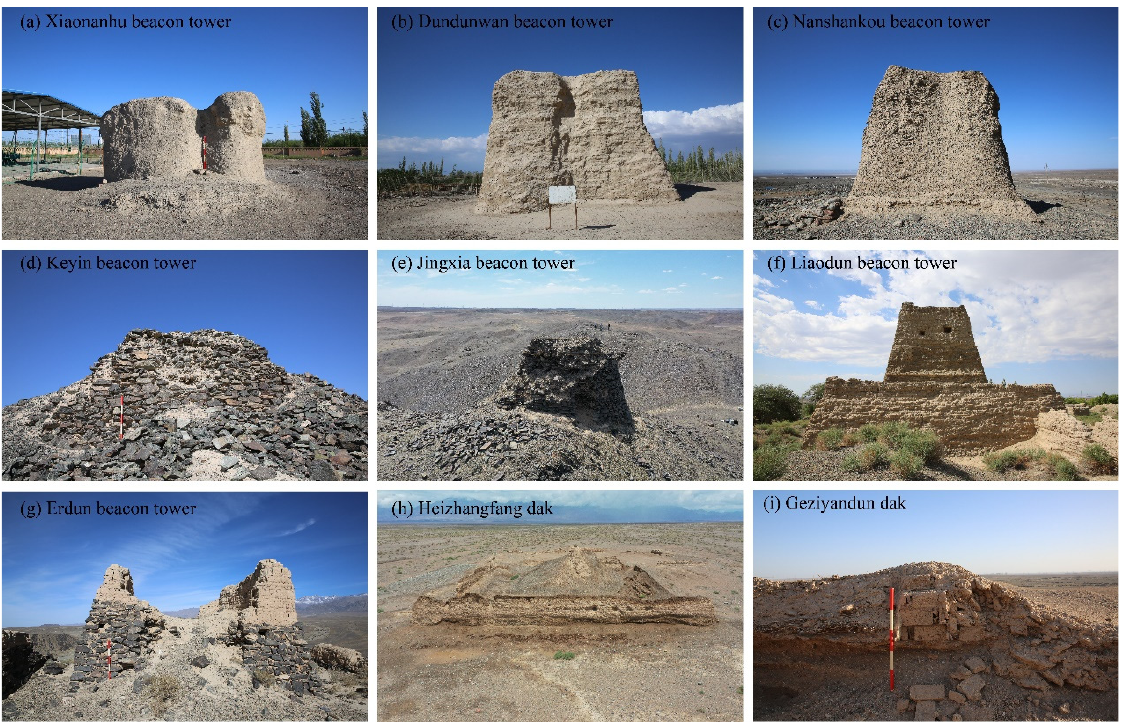
Figure 2. Photographs of typical beacon towers and dak sites in the eastern Tienshan Mountains.